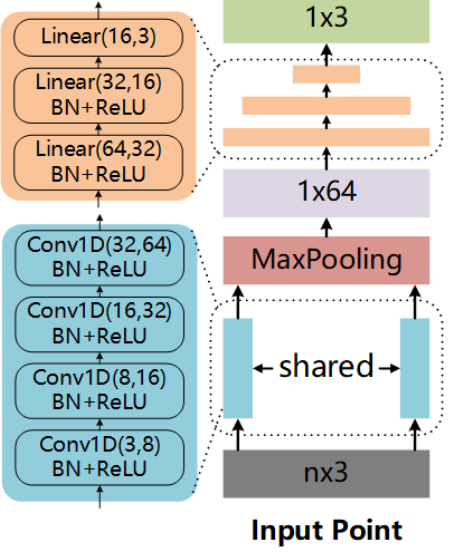
Figure 10. The architecture of